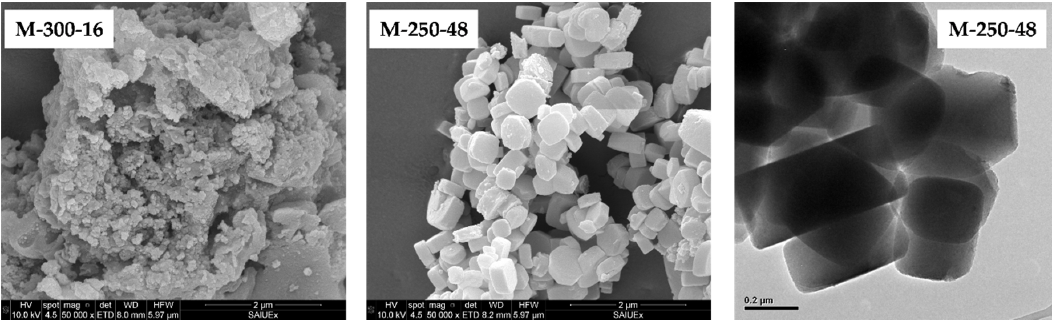
Figure 8. SEM image of M-300-16. SEM and TEM images of M-250-48.